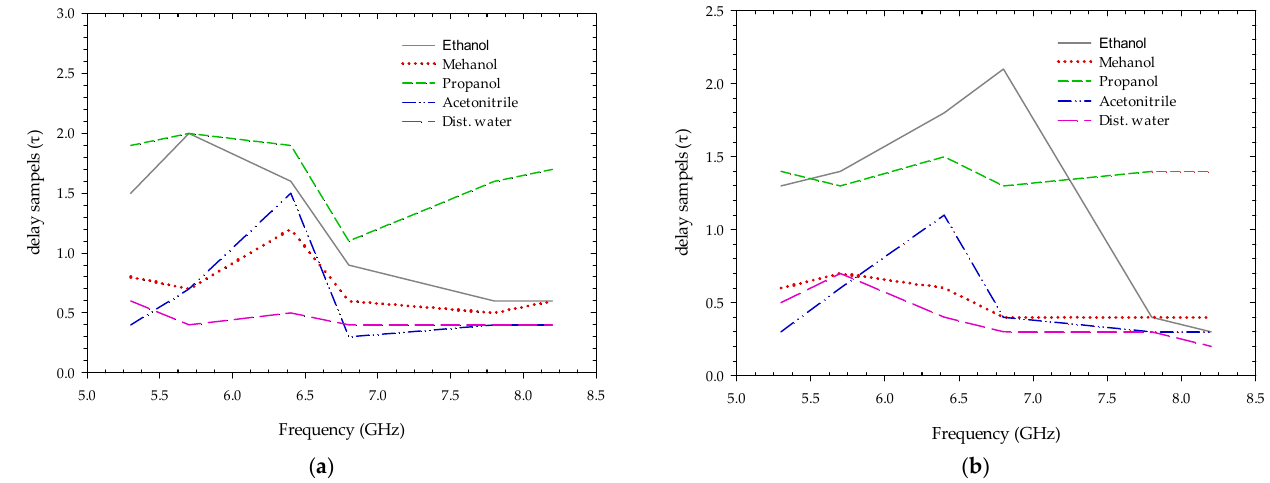
Figure 13. Delay in samples at different transmitting impulse frequencies trough MUT using ( a ) podal antenna; ( b ) antipodal antenna.